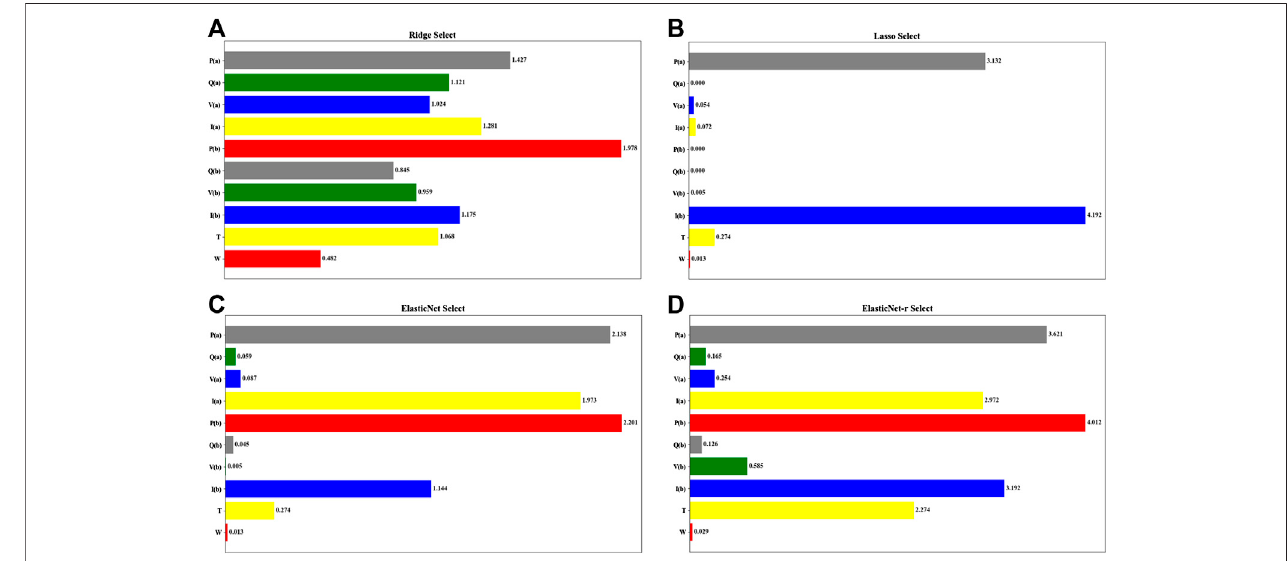
FIGURE 2 | Comparison of the selection results of different algorithms with strong in fl uence.